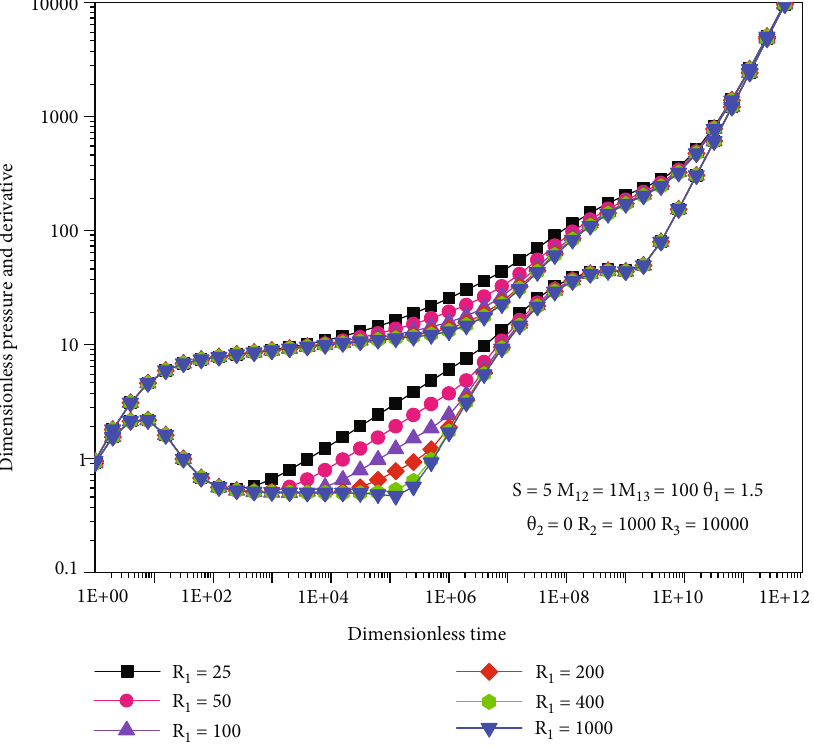
Figure 8: In fl uence of the radius of the inner zone of the three-zone homogeneous radial composite reservoir on the well bottom pressure performance.